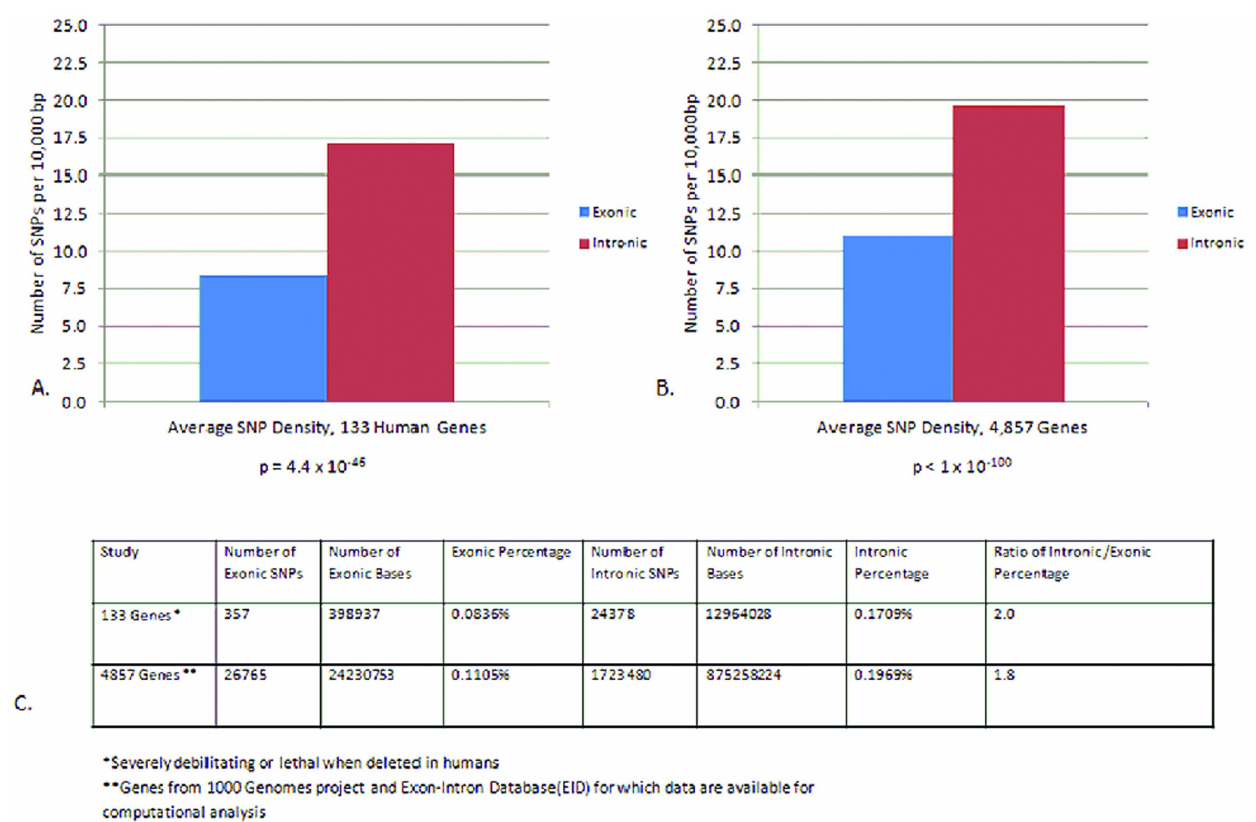
Figure 1. SNP incidence in human intronic and exonic DNA. A: SNPs in 133 human genes known to be lethal or severely debilitating if deleted [90] (Table S1); B: Survey of 4857 human genes for which intron/exon boundaries are readily definable in the Exon-Intron Database